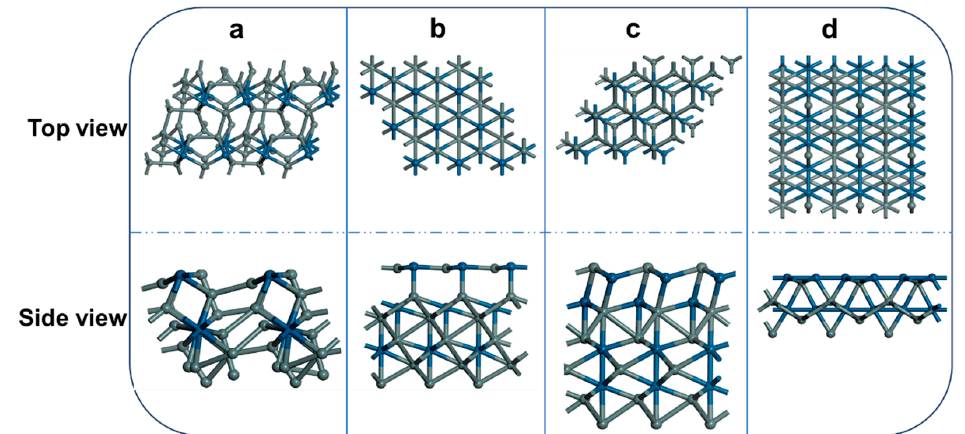
Figure 2. Schematic ball and stick model of the Sn–Pt alloy surfaces showing the top and side view, where ( a ) Sn 4 Pt, ( b ) Sn 3 Pt 2 ( c ) Sn 2 Pt, and ( d ) SnPt. The blue and grey balls are the Pt and Sn atoms, respectively.